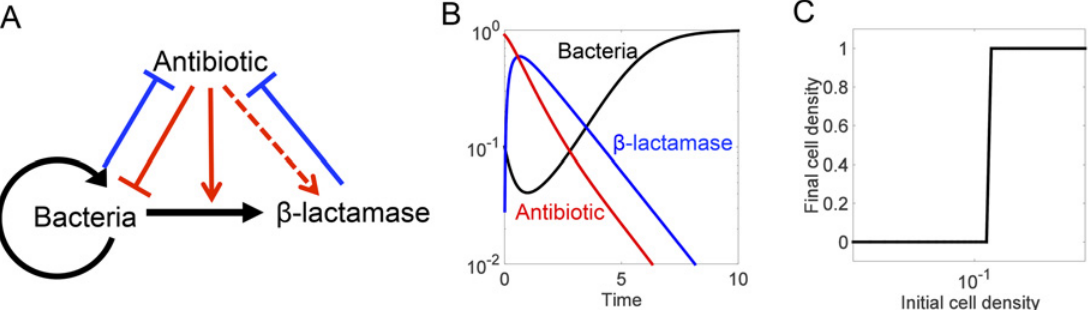
Fig 1. Mechanism and dynamics of antibiotic-mediated death. (A) Antibiotic-mediated death . Black represents bacterial actions, blue represents Bla actions, and red represents antibiotic actions. Arrows denote induction or activation; T-lines indicate inhibition; the dashed arrow represents the ability for the model to simulate inducible or constitutive Bla production. (B) Typical time courses of bacterial density, antibiotic, and Bla after one dose of antibiotic treatment . The antibiotic can cause cell lysis, which triggers the release of Bla into the environment. Sufficient degradation of the antibiotic by the Bla allows the surviving bacteria to recover. (C) Collective tolerance . A bacterial population can only recover from an antibiotic dose if enough bacteria are present for sufficient Bla to be